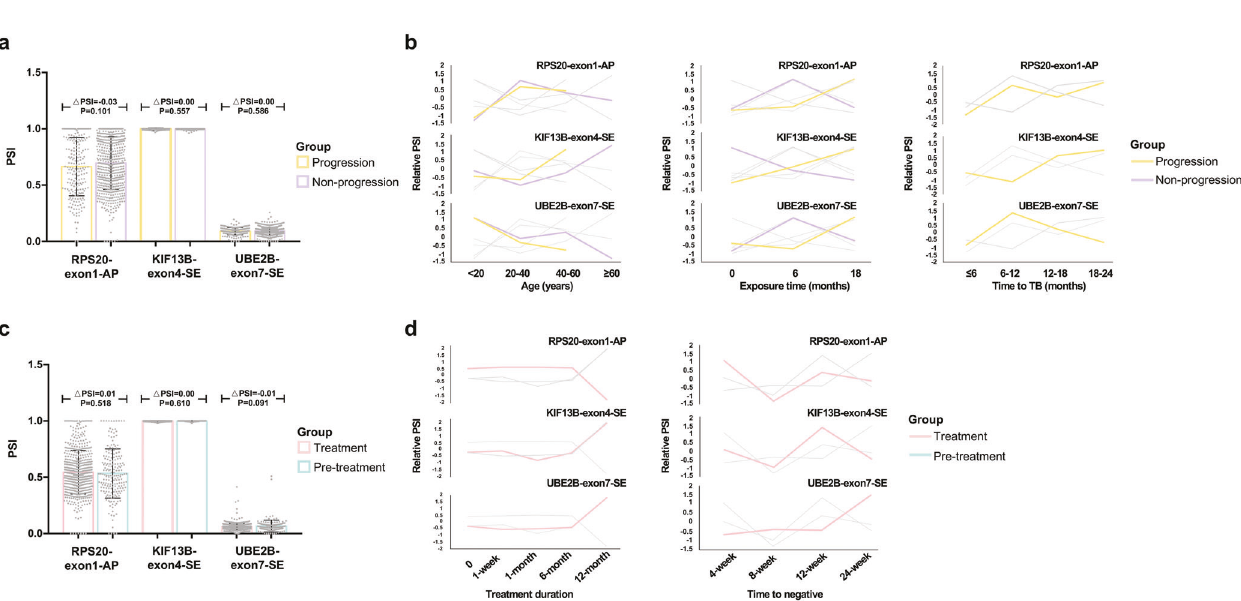
Fig. 3 The splicing of target three events in the TB-progression and treatment cohorts. a Bar plots of the target three splicing events in the TB- progression cohort. b The Muffz analysis showing the splicing of three events over age, exposure time, and time to TB. c Bar plots of the three splicing events in the TB-treatment cohort. d The Muffz analysis showing the splicing of the target three events over treatment duration and time to negative. PSI percent spliced in, RPS20 Ribosomal Protein S20, AP alternate promoter, KIF13B Kinesin Family Member 13B, SE skipping exon, UBE2B Ubiquitin Conjugating Enzyme E2 B, TB tuberculosis